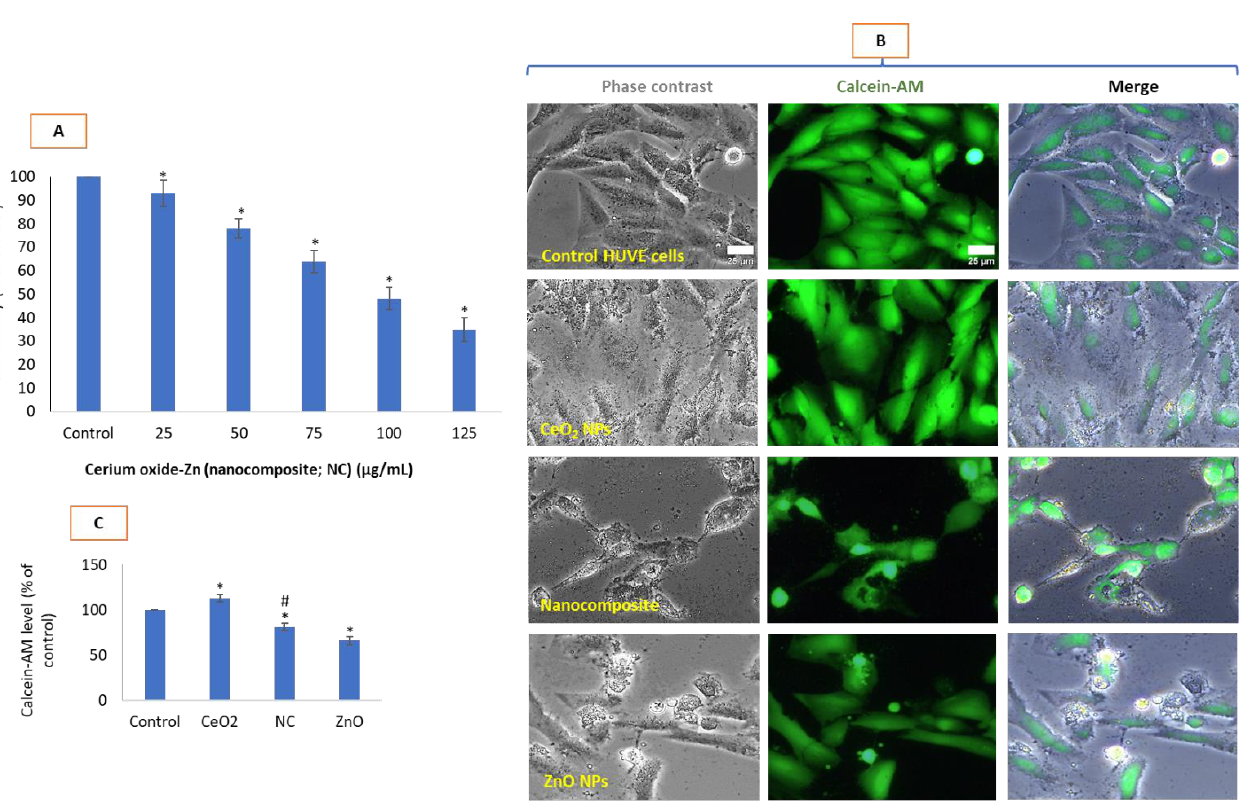
Figure 2. Potential cytotoxicity in HUVECs due to CeO 2 -Zn nanocomposite at concentrations indi- cated ( A ). Cell morphology under phase contrast in ( B ) and calcein-AM fluorescence (green images in ( B )) is provided as direct observation of cell damages caused by designated treatments. Calcein-AM fluorescence intensity from calcein-AM images present in Figure 2B is plotted as bar diagram and is given as Figure ( C ). In all subsequent figures of the bar diagram and image, CeO 2 and CeO 2 NP both refer to 100 µg/mL of CeO 2 NPs. NC and nanocomposite both refer to IC50 of CeO 2 -Zn nanocomposite. ZnO and ZnO NP both refer to IC50 of ZnO NPs. In horizontal axis of each bar diagram given, NPs of CeO 2 and ZnO were denoted simply as CeO 2 and ZnO, respectively, while the nanocomposite of CeO 2 -Zn as NC due to limited space there. In images, names are in full form. Merge refers to the images obtained after color merging of phase-contrast and calcein-AM images. IC50s calculations were performed using the online IC50 calculator (https://www.aatbio.com/tools/ic50-calculator, represents 25 µ m which is only provided in control images as a matter of convention. Each image was captured by a 40 × objective under uniform conditions of illumination intensity, time and other variables. Each experiment was performed in triplicates ( n = 3). * statistically significant difference from the control ( p < 0.05). # statistically significant difference in between treatments of CeO 2 -Zn nanocomposite and ZnO NP ( p <